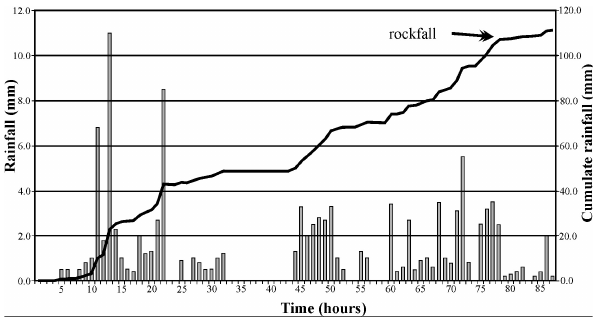
Fig. 9. Antecedent and cumulative rainfalls recorded at the Sarno Sanatorio rain gauge from 19:00LT on 6 January to 05:00LT on 10 January